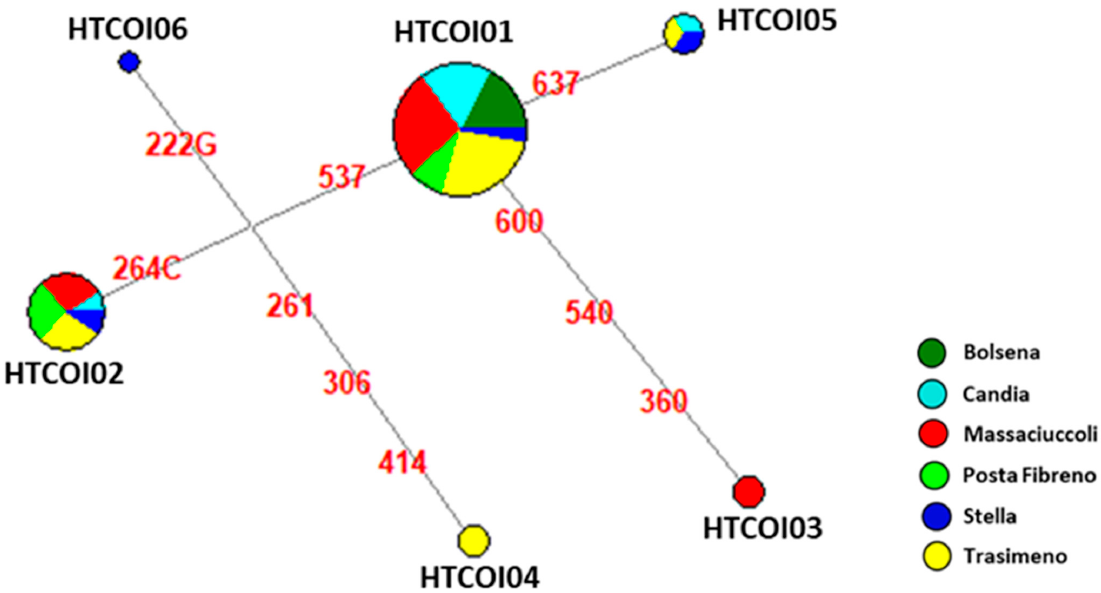
Figure 2. Median-Joining Network based on 53 COI sequences (nps 78–651) belonging to six P. clarkii populations from Italy. Circles represent the haplotypes and are proportional to the observed frequency in 53 samples (Table S2), while colors indicate the different basins: Bolsena (dark green), Candia (light blue), Massaciuccoli (red), Posta Fibreno (light green), Stella River (blue) and Trasimeno (yellow).